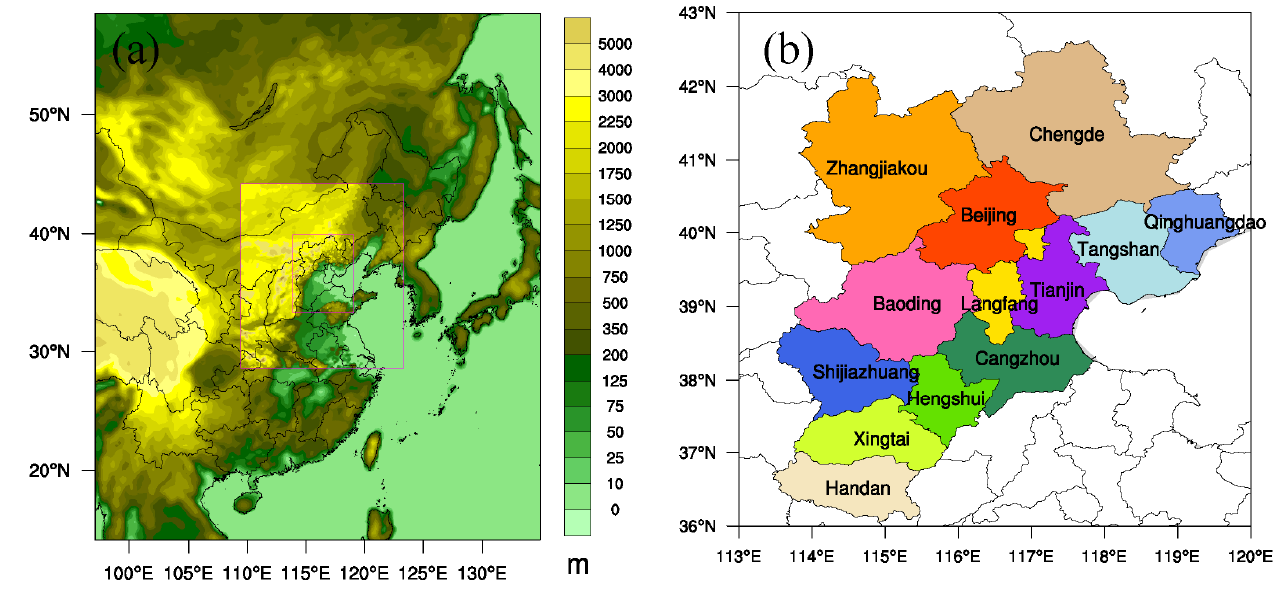
Figure 1. ( a ) Three nested domains for WRF-Chem model simulations with topography (in units of m); ( b ) map showing the cities in BTH region with CTGC and CTEC implemented.